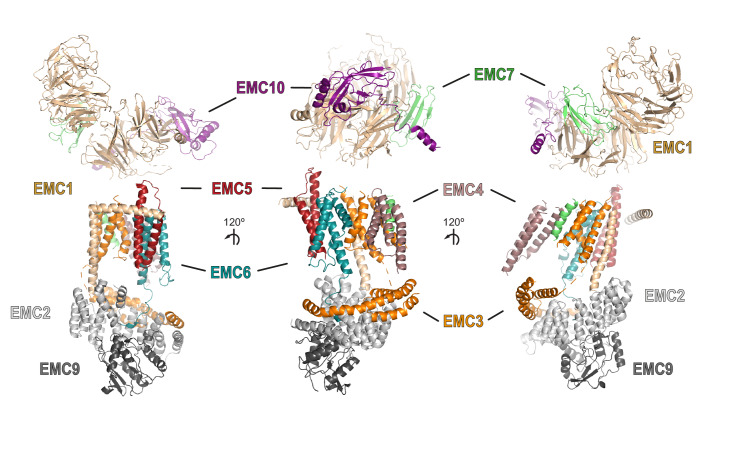
Views of the composite EMC model.Shown are multiple views of the composite EMC model which contains all nine EMC subunits. Where possible, the same color scheme as used throughout the main figures was employed with EMC1 (tan), EMC2 (light grey), EMC3 (orange), EMC4 (dark pink), EMC5 (red), EMC6 (teal), EMC7 (lime), EMC9 (dark grey), and EMC10 (purple).